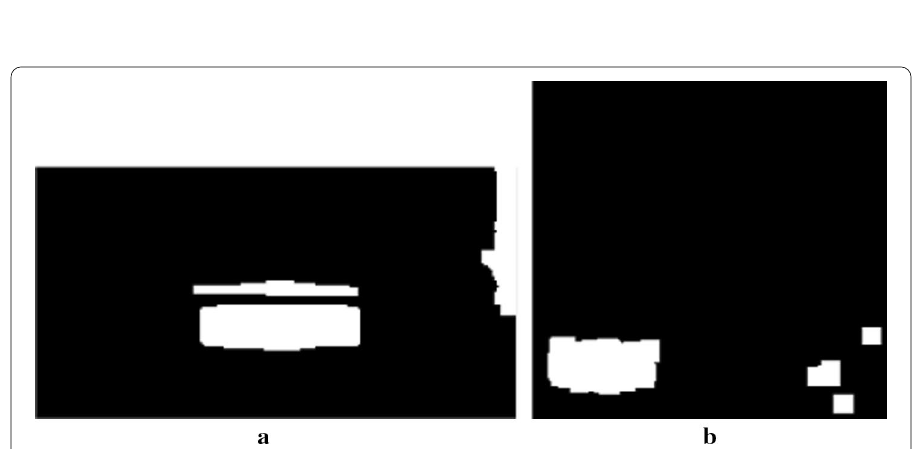
Fig. 5 a License plate with white background. b Colored background after morphological